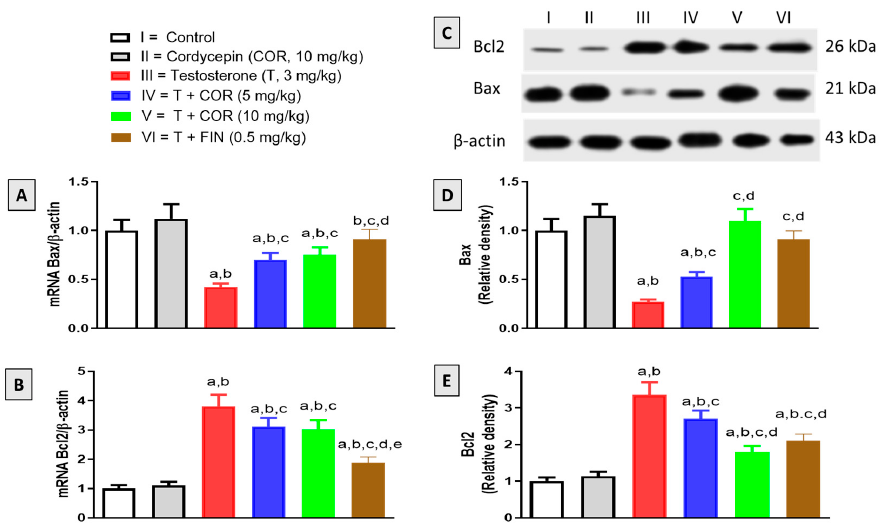
Figure 4. Cordycepin effect on prostatic expression of Bax ( A ) and Bcl2 ( B ) mRNAs and proteins ( C ) in testosterone-treated rats. Lanes I, II, III, IV, V, and VI represent control, cordycepin, testosterone, testosterone + cordycepin 5 mg/kg, testosterone + cordycepin 10 mg/kg, and testosterone + finasteride, respectively. Densitometric data of Bax and Bcl2 protein expression are demonstrated in bar charts ( D , E ), respectively. Data presented in the charts are mean ± SD. For mRNA and protein expression studies, n = 6 and 3, respectively. COR = cordycepin, T = testosterone, FIN = finasteride. a, b, c, d or e: significantly different ( p < 0.05) from control, cordycepin, testosterone, T + COR (5 mg/kg) or T + COR (10 mg/kg), respectively.